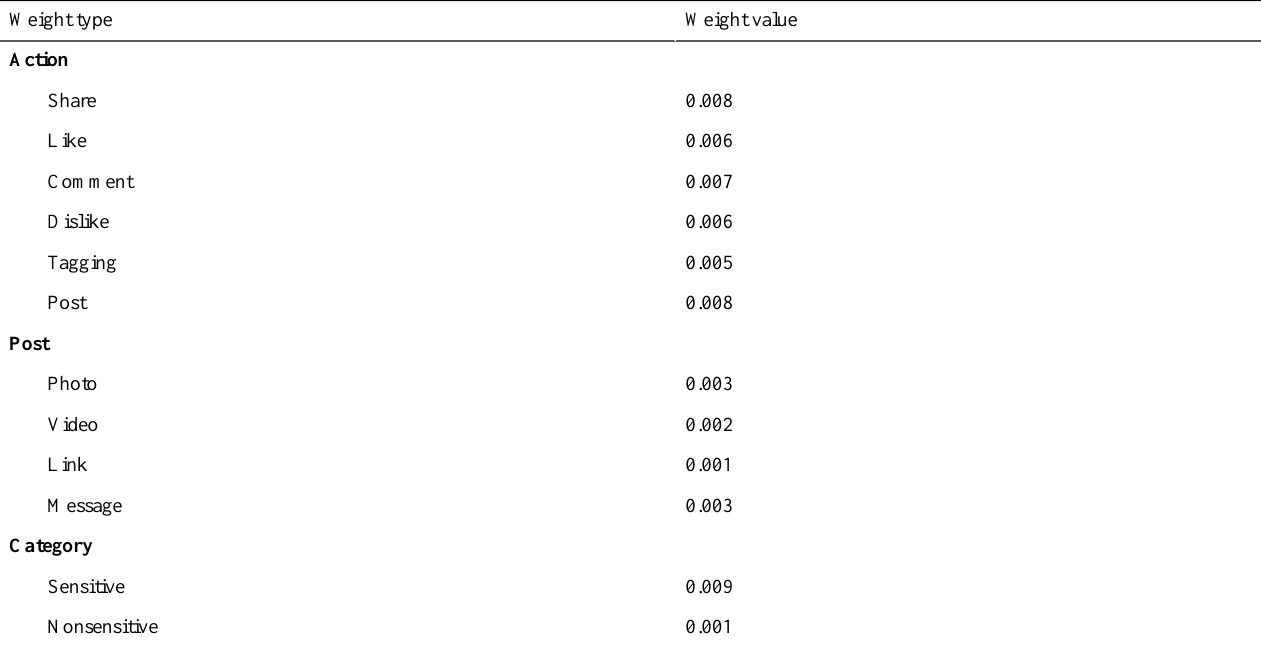
Table 3. Weighted clusters in the action-based trust